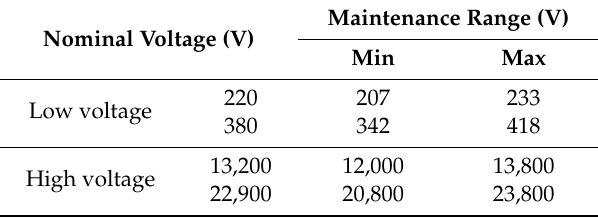
Table 2. The nominal voltage of distribution line.